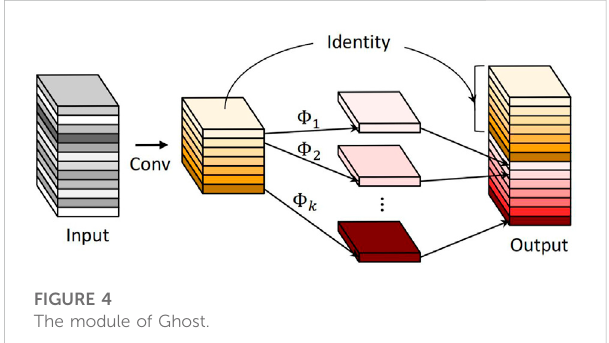
FIGURE 4 The module of